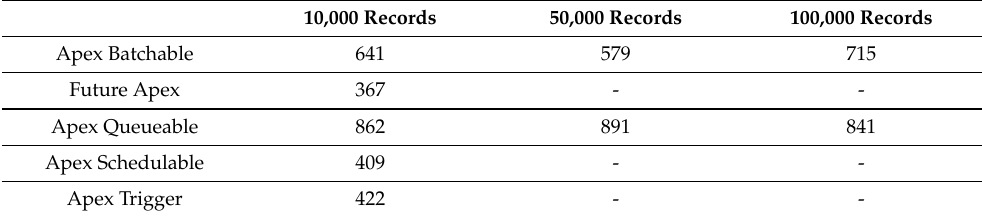
Table 15. The number of records processed in one second for update operation.